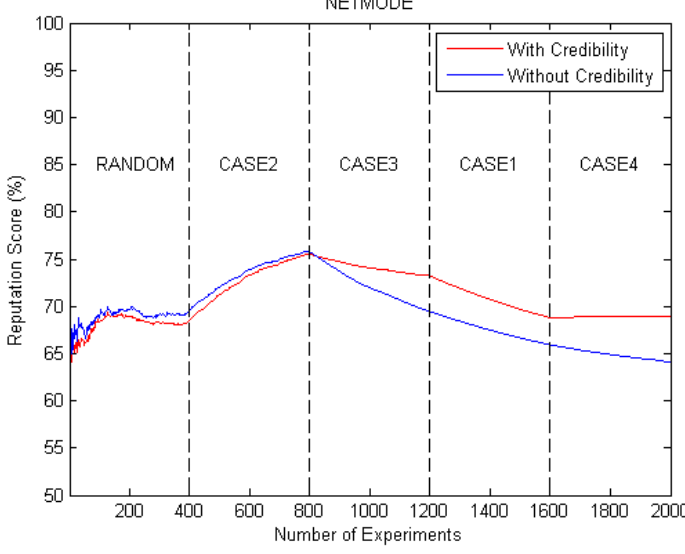
Figure 3. Credibility mechanism effect on the fuzzy VIKOR reputation